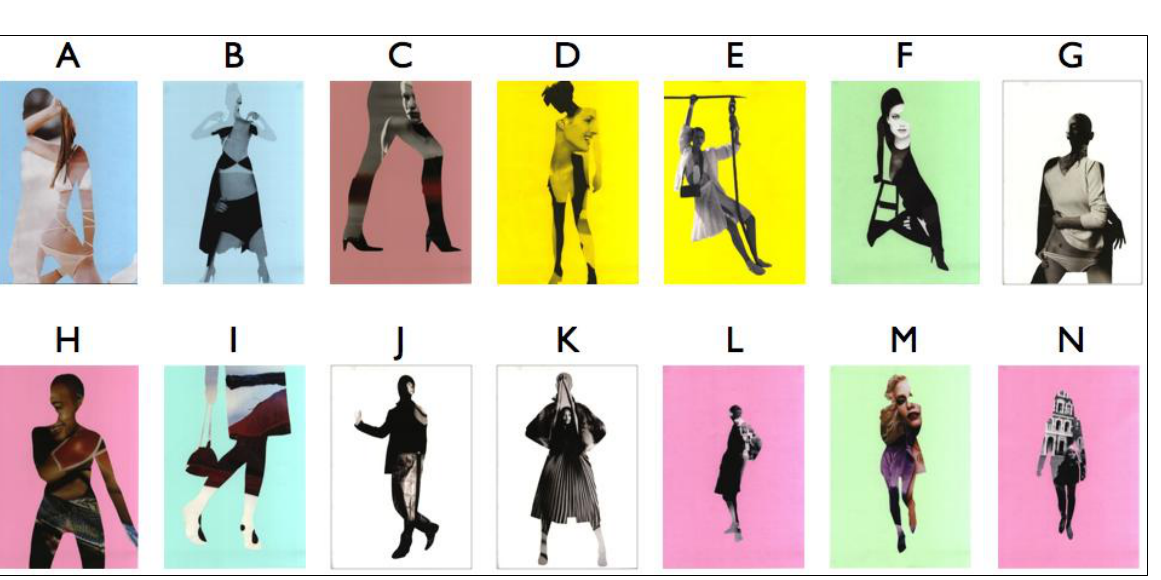
Figure 1. Pictures used in the study.